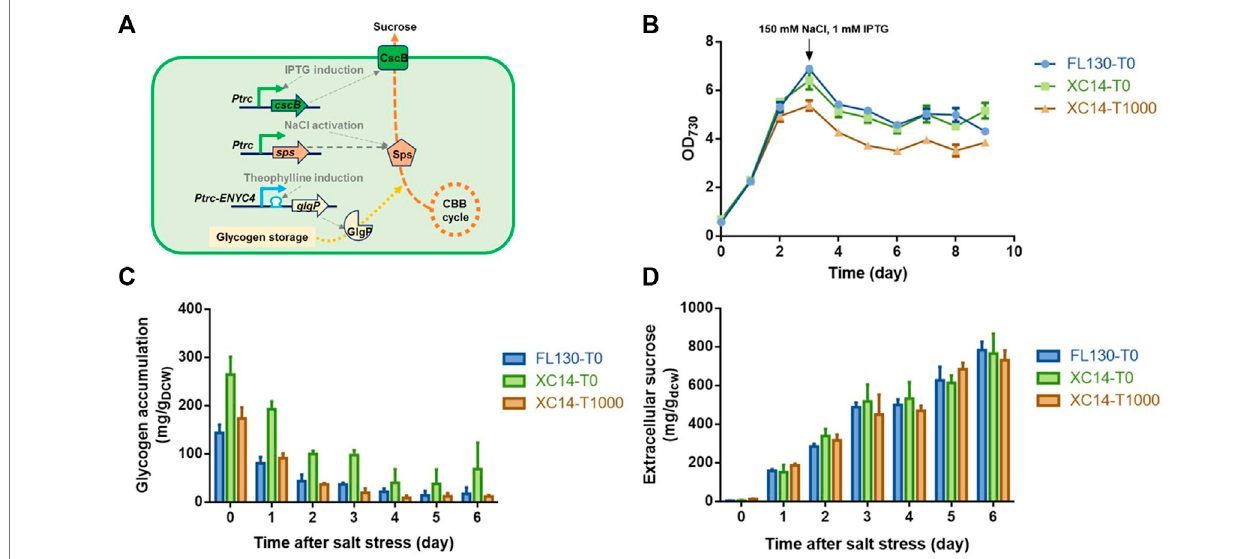
FIGURE 5 | Effects of theophylline-induced glgP overexpression on salt-induced sucrose synthesis and secretion in PCC 7942 cell factories. (A) Design and working mode of the theophylline-regulated glgP expression system in a previously constructed sucrose-synthesizing strain FL130. The expression of the cscB gene would be induced by the addition of IPTG, facilitating sucrose secretion out of the cells. An additional copy of the native sucrose-6-phosphate synthase gene would be expressedbyaconstitutivestrongpromoter Ptrc ,andwhensaltstresswasimposed,theintracellularSpswouldbeactivatedbyincreasedconcentrationsofNaCl, leadingtoenhancedsucrosesynthesiswiththecarbonsourcefromCBBcycleandglycogenstorage.Thepromotersequenceofthenative glgP genewouldbereplaced withthe Ptrc-ENYC4 system, and theaddition oftheophylline would leadtooverexpression of glgP and enhanced glycogen degradation. Thestrainderivedfrom FL130 was termed XC14. (B) Cell growths, (C) glycogen storage, and (D) extracellular sucrose production of FL130 and XC14 (with or without theophylline induction) strains before and after salt stress on Day 3. T0 and T1000 represented theophylline concentrations of 0 and 1,000 μ M,